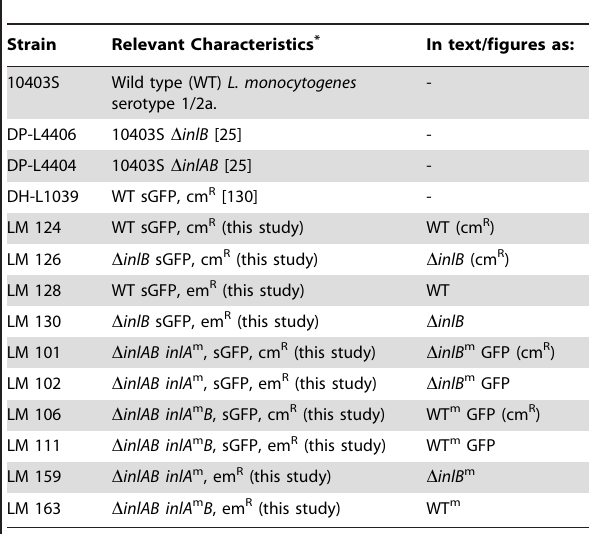
Table 2. L. monocytogenes Strains Used in This